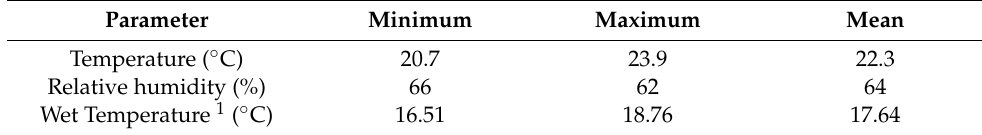
Table 2. Environmental conditions inside the greenhouse.